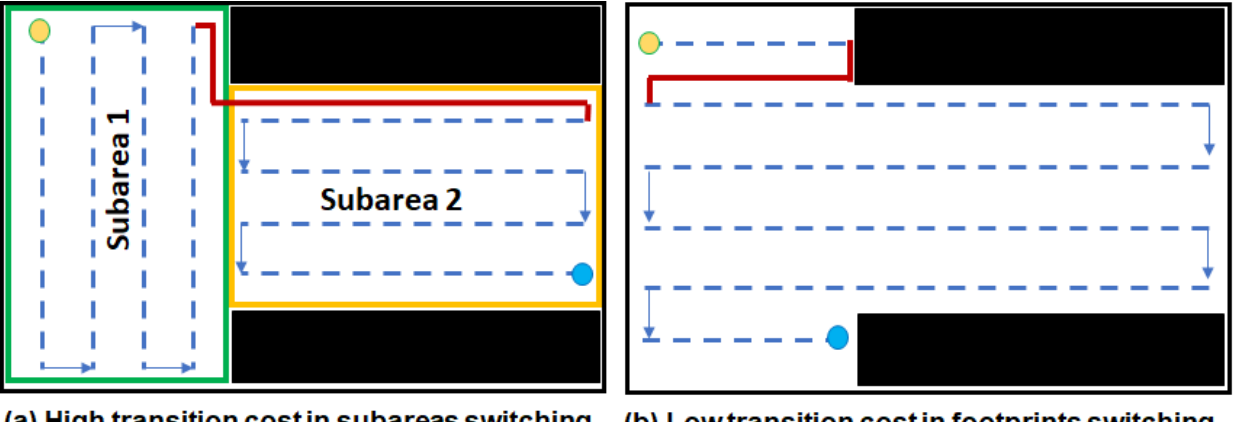
Figure 14. Transition distance comparison between the proposed ( b ) and existing methods ( a ).